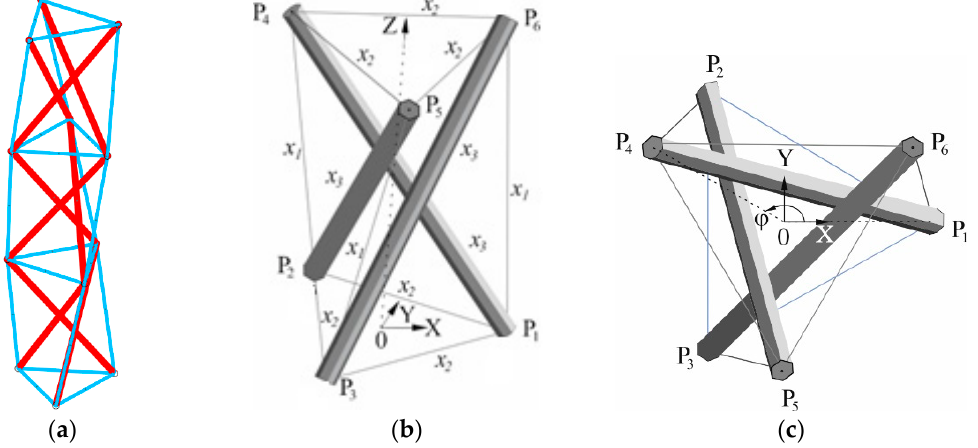
Figure 1. Reference configuration of the tensegrity simplex: ( a ) tensegrity column; ( b ) spatial view the tensegrity simplex; ( c ) top view of the tensegrity simplex ϕ = 5 π